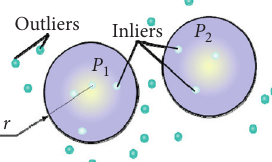
Figure 7: Schematic diagram of ROR filtering